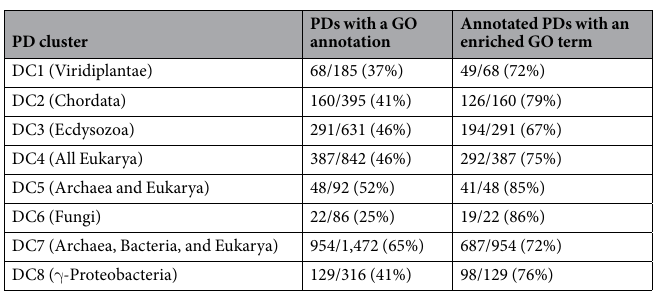
Table 2. Statistics of annotated and enriched GO terms for the eight PD